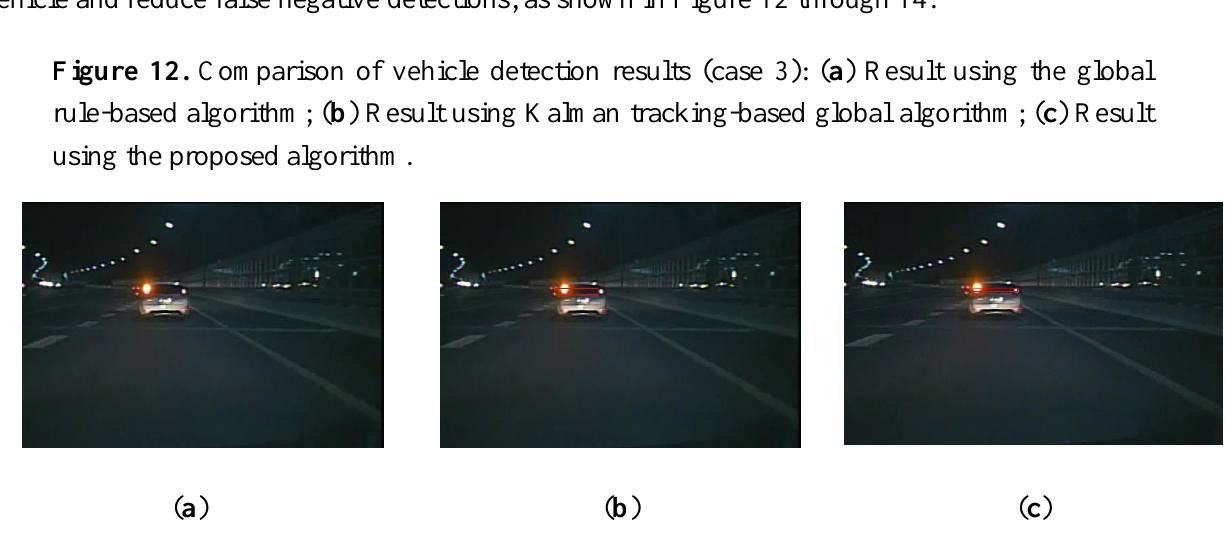
Figure 13. Comparison of vehicle detection results (case 4): ( a ) Result using the global rule-based algorithm; ( b ) Result using Kalman tracking-based global algorithm; ( c ) Result using the proposed